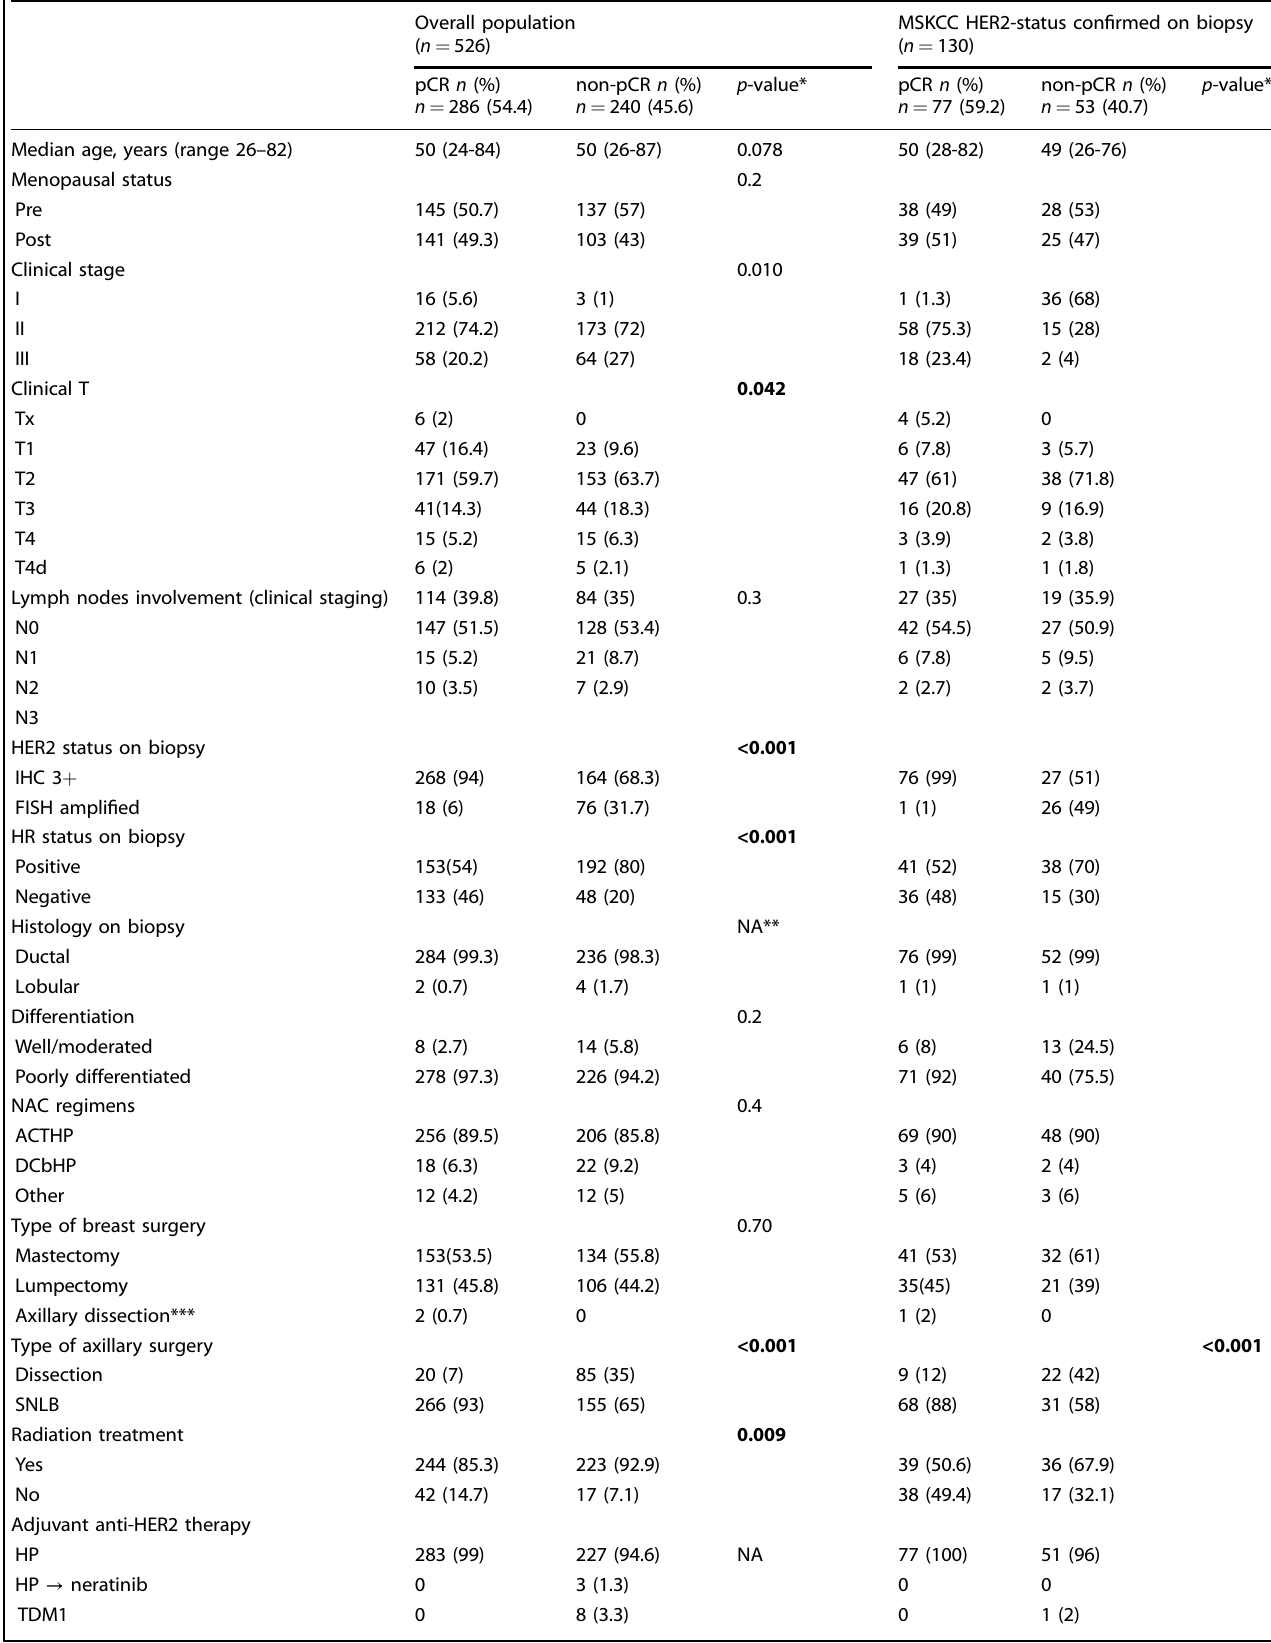
Table 1. Patients ’